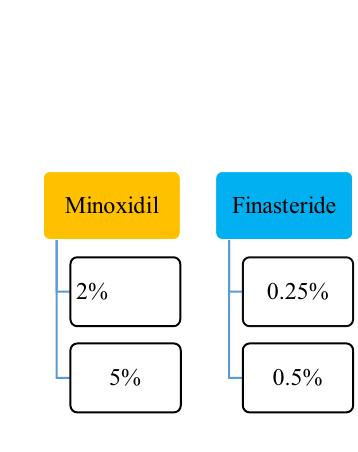
Fig. 3 % drug effectiveness of FDA approved drugs